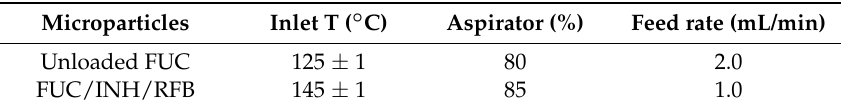
Table 1. Operating parameters of the spray-drying